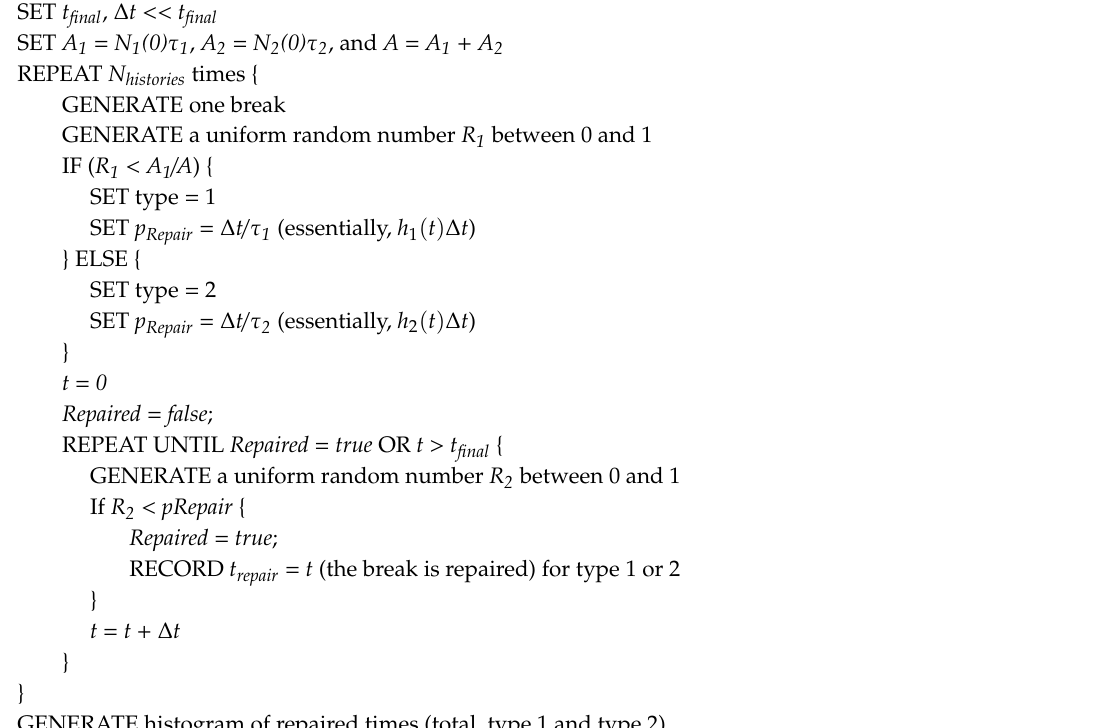
Algorithm 1 : Simulation of repair kinetics for a mixture of two types of breaks SET t final , ∆ t << t final